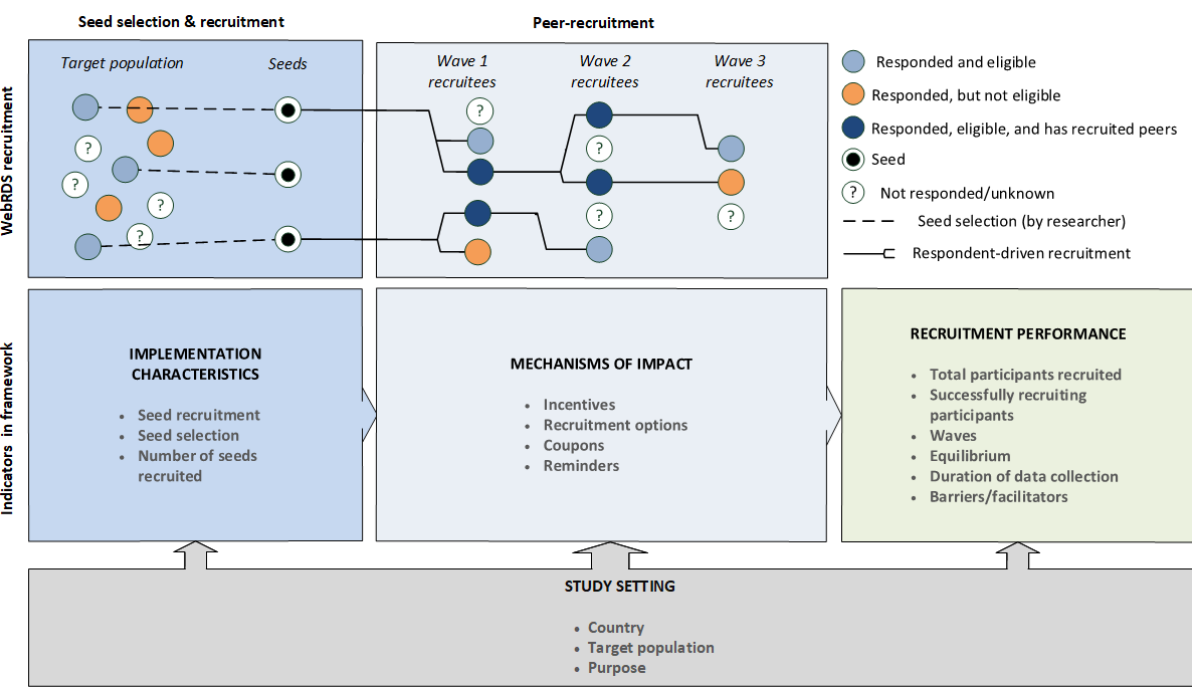
Figure 1. Analytical framework for web-based RDS recruitment performance (adapted from